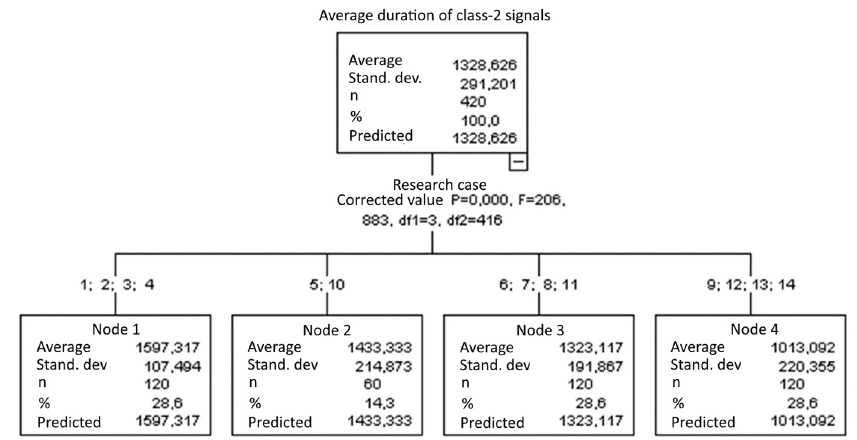
Figure 21. Classification tree for the average duration of class-2 signals.